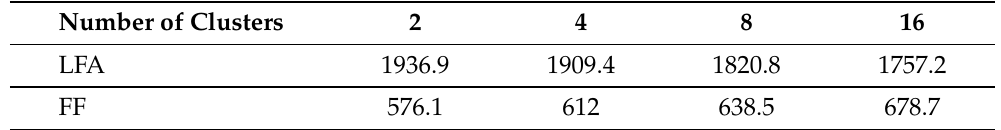
Table 4. Targets found when increasing the number of clusters— Scenario 3